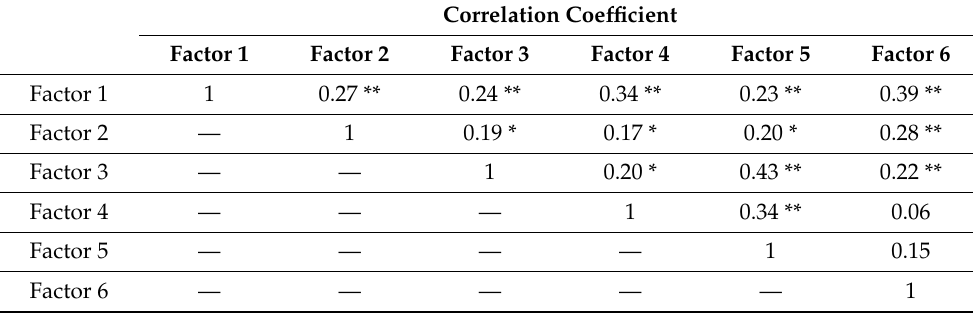
Table 4. Correlation between factors of the 37-item PES-J.